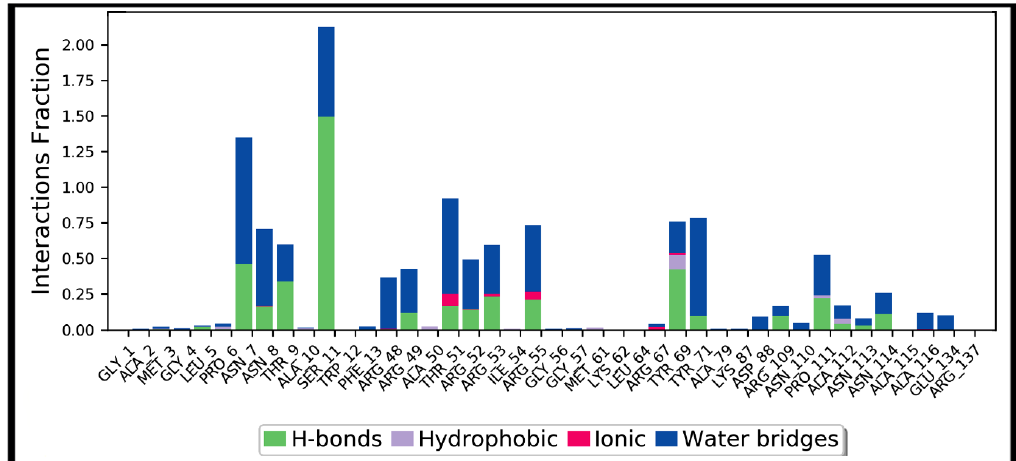
Figure 9. Protein interactions with teicoplanin, monitored throughout the simulation trajectory. These interactions are clustered by type and summarized in bar diagram including hydrogen bonds (H-bonds), hydrophobic, ionic, and water bridges. Ala: alanine; Arg: arginine; Asn: asparagine; Asp: aspartic acid; Cys: cysteine; Gln: glutamine; Glu: glutamic acid; Gly: glycine; His: histidine; Leu: leucine; Met: methionine; Phe: phenylalanine; Pro: proline; Ser: serine; Thr: threonine; Tyr: tyrosine; Val: valine. The number of corresponding amino acid residue is according to the crystallographic information obtained from the protein data bank.